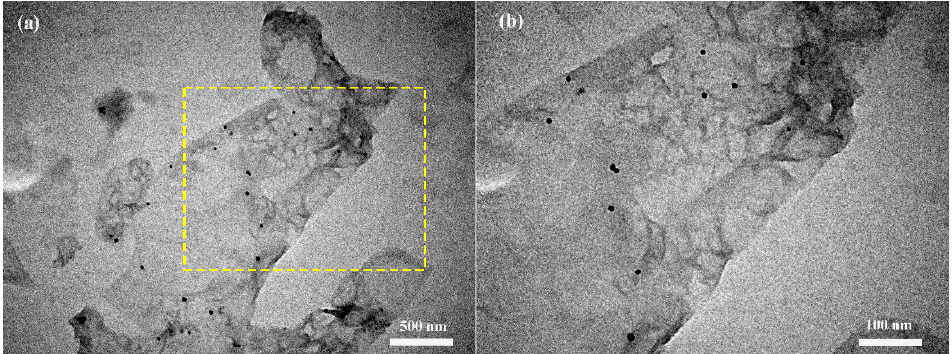
Figure 4. ( a ) A TEM images of rGO/Au; ( b ) An enlarged image of selected area.